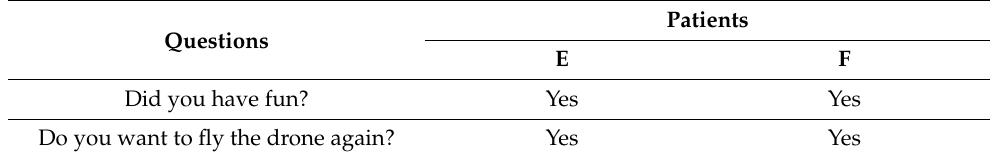
Table 12. Questionnaire results in the principal outdoor experiment.